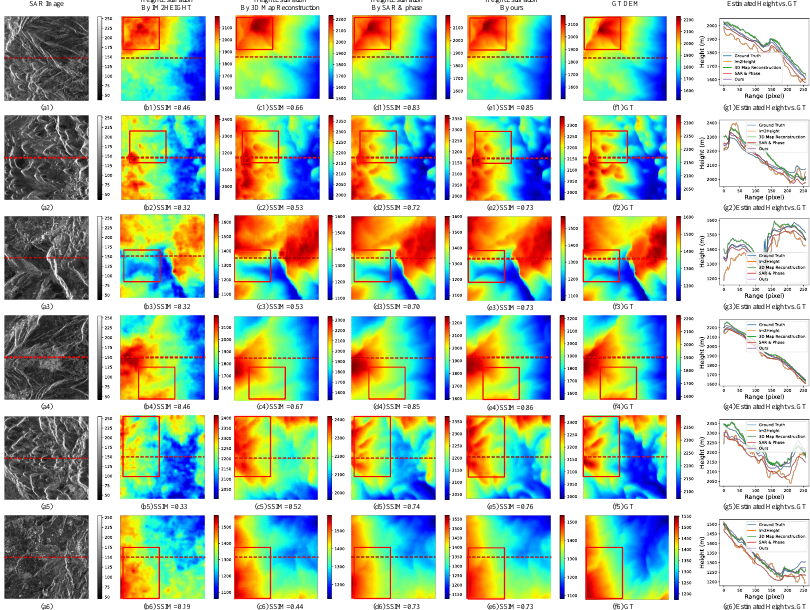
Figure 9. Six local height patches estimated by different methods in Guiyang datasets. From the left to right, ( a1 – a6 ) are the SAR images. ( b1 – b6 , c1 – c6 , d1 – d6 , e1 – e6 ) are the estimated height map by IM2HEIGHT, 3D Map Reconstruction, SAR&phase and our method, respectively. ( f1 – f6 ) are the ground truth height maps. Elevation lines along range directions with a fixed middle azimuth value marked by red dash lines in ( a1 – f1 ), ( a2 – f2 ), ( a3 – f3 ), ( a4 – f4 ), ( a5 – f5 ), ( a6 – f6 ) are plotted in ( g1 – g6 ) respectively. The downsampling factors of SH are 96 ×